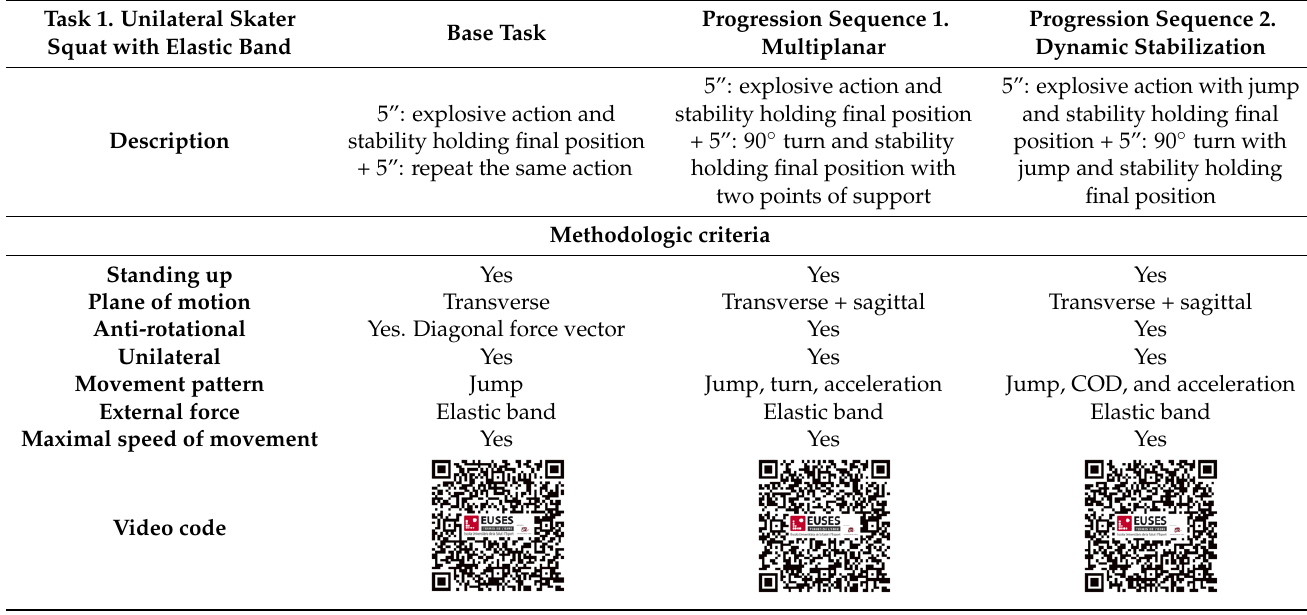
Table 1. Description and methodologic criteria of SCS group’s task 1 and its progressions.